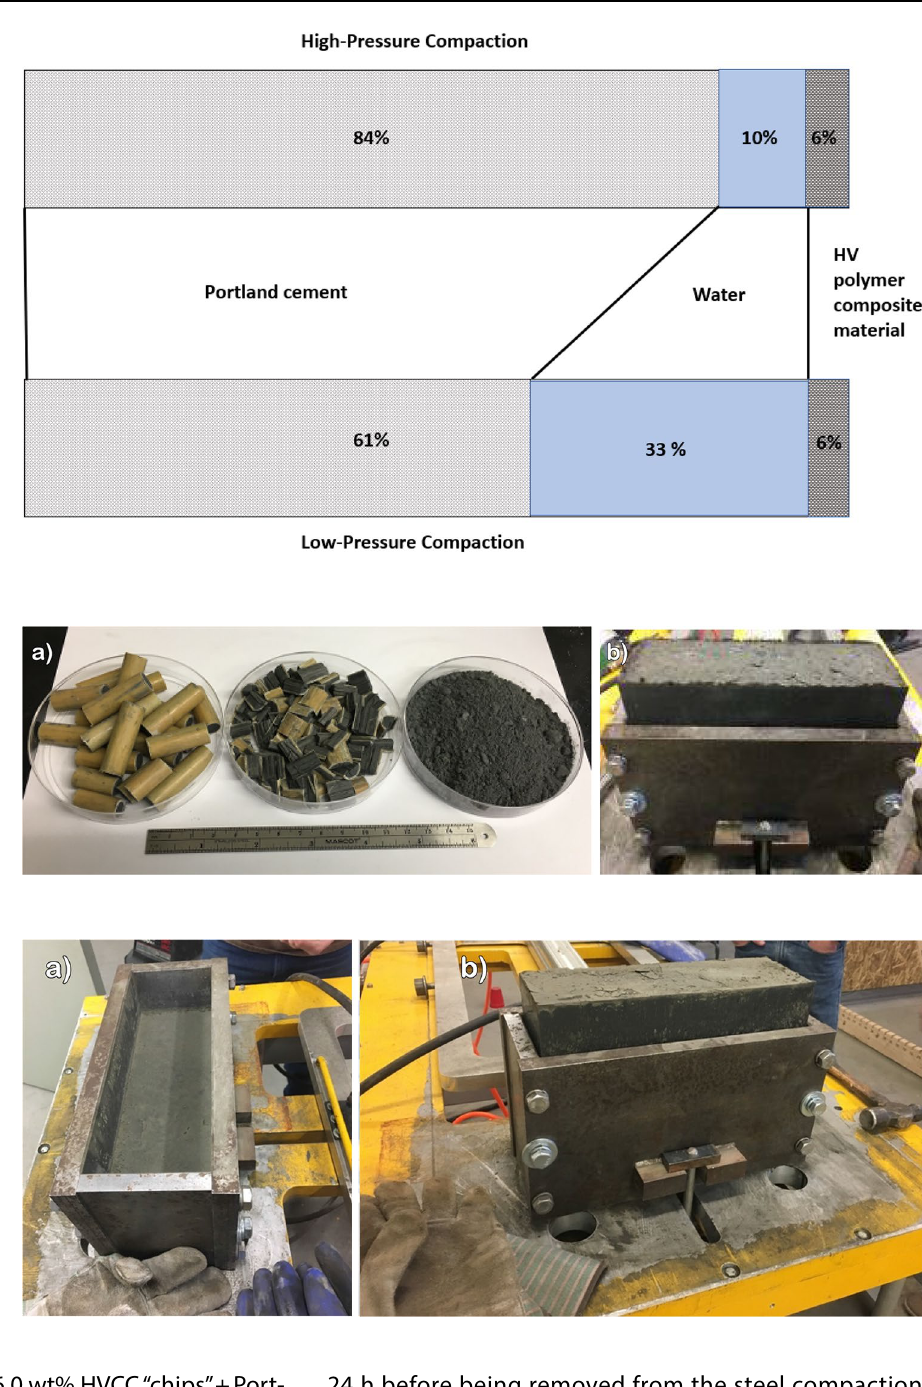
Fig. 3 Comparison of total mass percentages of materials for mixing designs high-pres- sure vs. low-pressure compac- tion